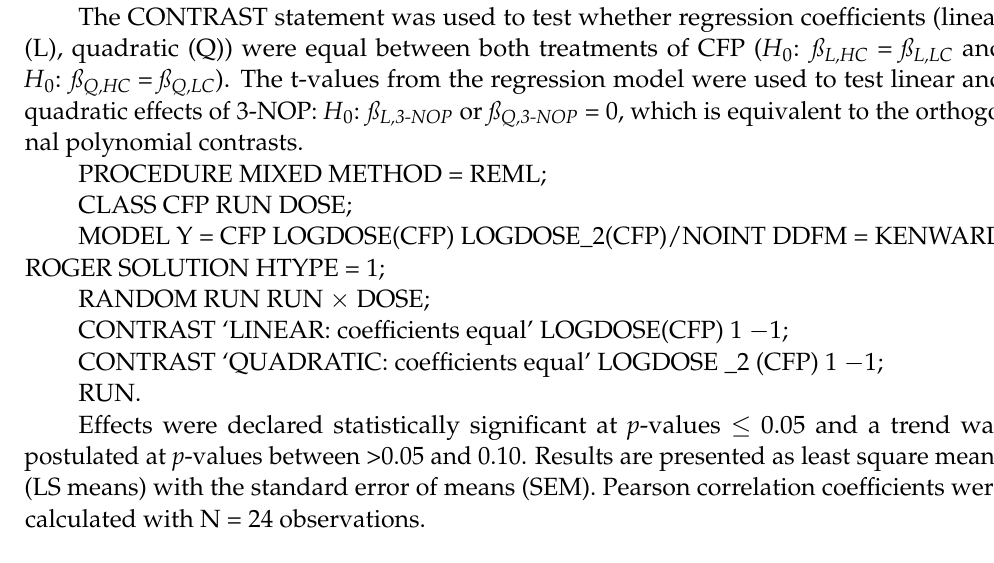
Table 2. Effects of 3-nitrooxypropanol (3-NOP) dosage levels (PLA: 0, LOW: 73, MED: 160, and HIGH: 1200 mg of 3-NOP/kg of feed DM) and low- (LC) or high- (HC) concentrate feed proportion in the diet (CFP) on dry matter degradation (DMD), apparent organic matter degradation (OMAD), and neutral-detergent fibre degradation (NDFD) (g/kg DM).